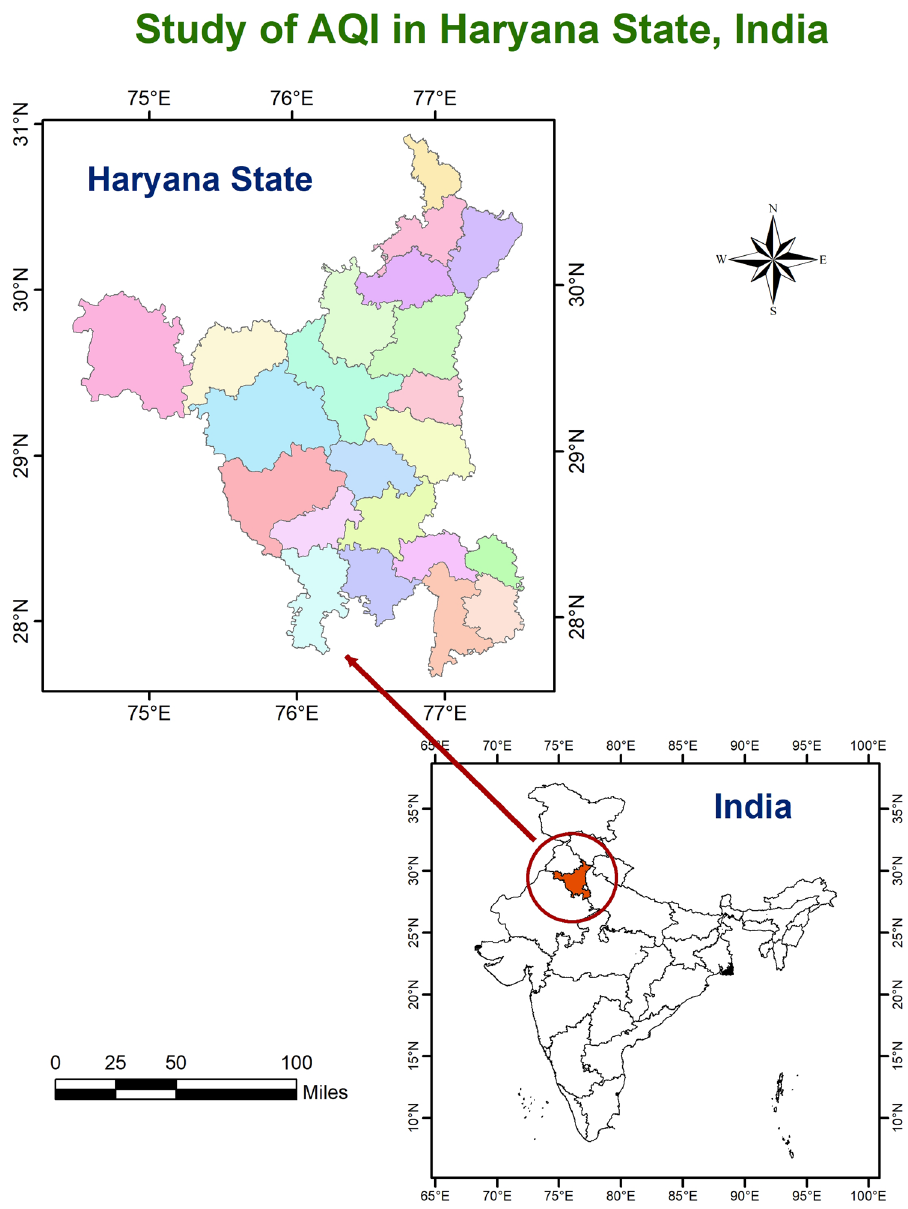
Figure 1. Represent the study location of air quality index